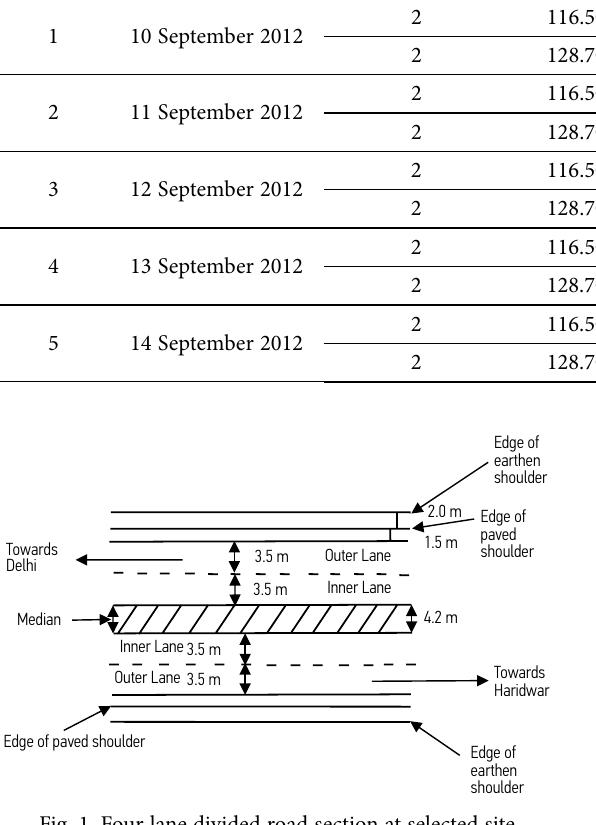
Fig. 1. Four lane divided road section at selected site of National Highway–58